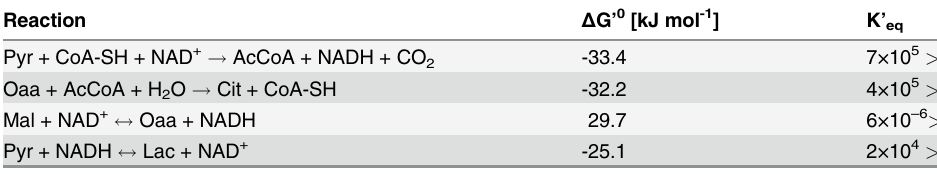
Table 4. Standard Gibbs free-energies for studied reactions and their equilibrium constants